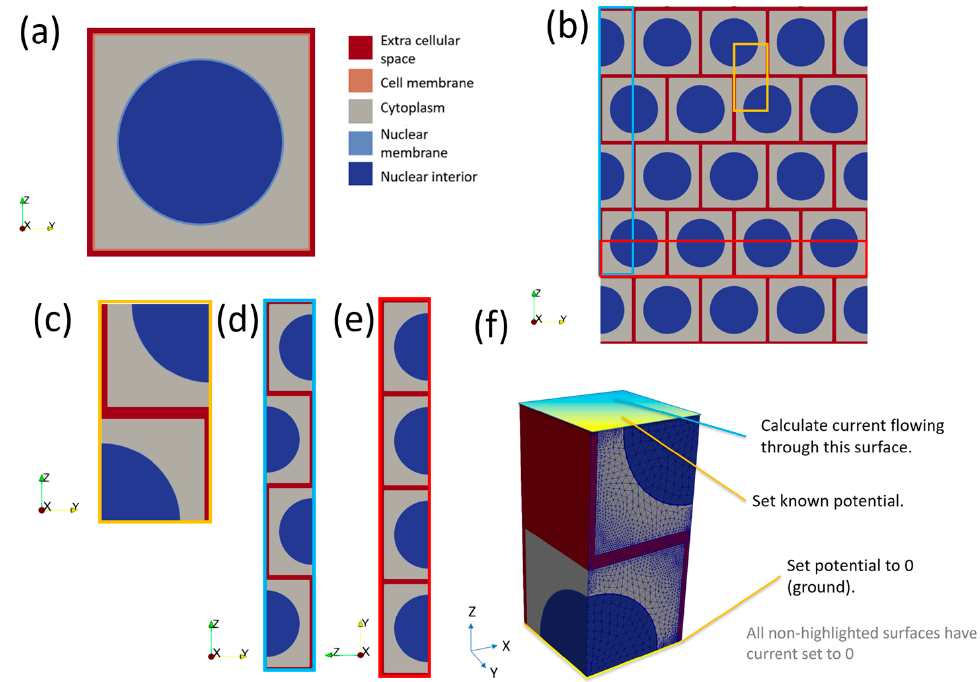
Figure 4. ( a ) Cross-section of a generic (nucleated) cell model of length 5 µ m. Note the cell and nuclear membranes have been exaggerated to make them visible. ( b ) Bricked layer representation of cells; note the pattern is assumed to repeat infinitely in the X direction (in/out of the page). ( c ) The smallest repeating unit of ( b ) in 2D. ( d ) The Z direction arrangement of cells. ( e ) The XY direction arrangement of cells. ( f ) The smallest repeating unit of ( b ) in 3D with boundary conditions applied to cellular scale model to calculate impedance.